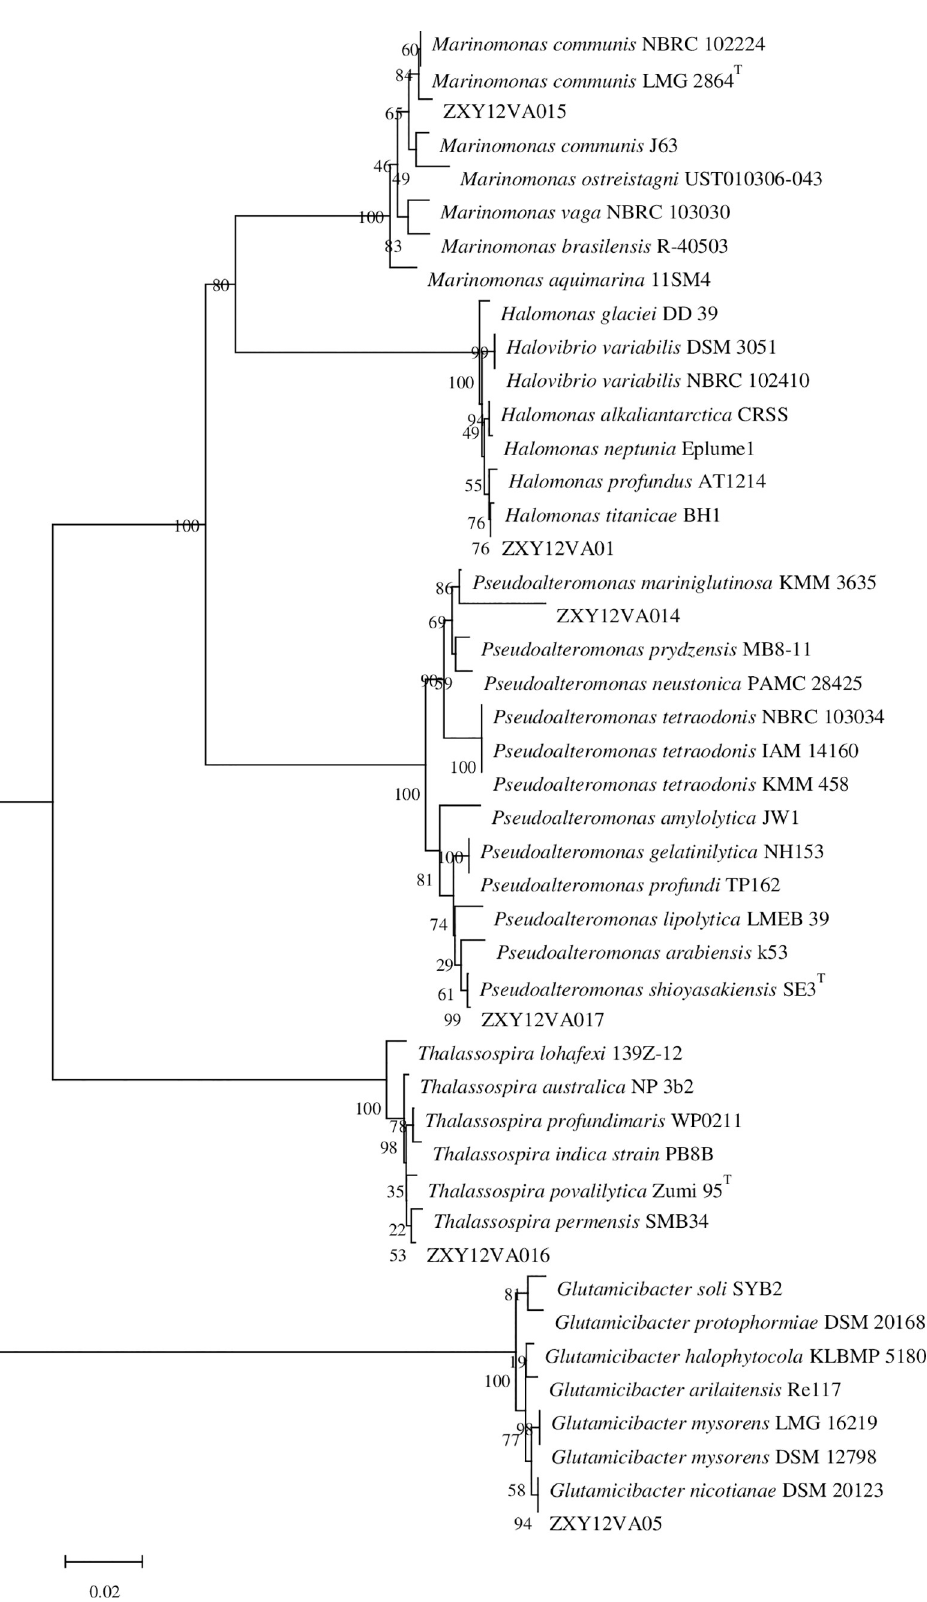
Fig 2. Phylogenetic tree of thermophilic isolates based on 16S rDNA sequences.